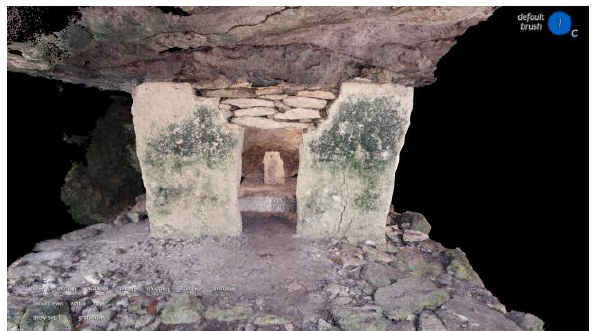
Figure 4. Point cloud (via SfM photogrammetry) of cave shrine XH-1, frontal view (note intact altar and